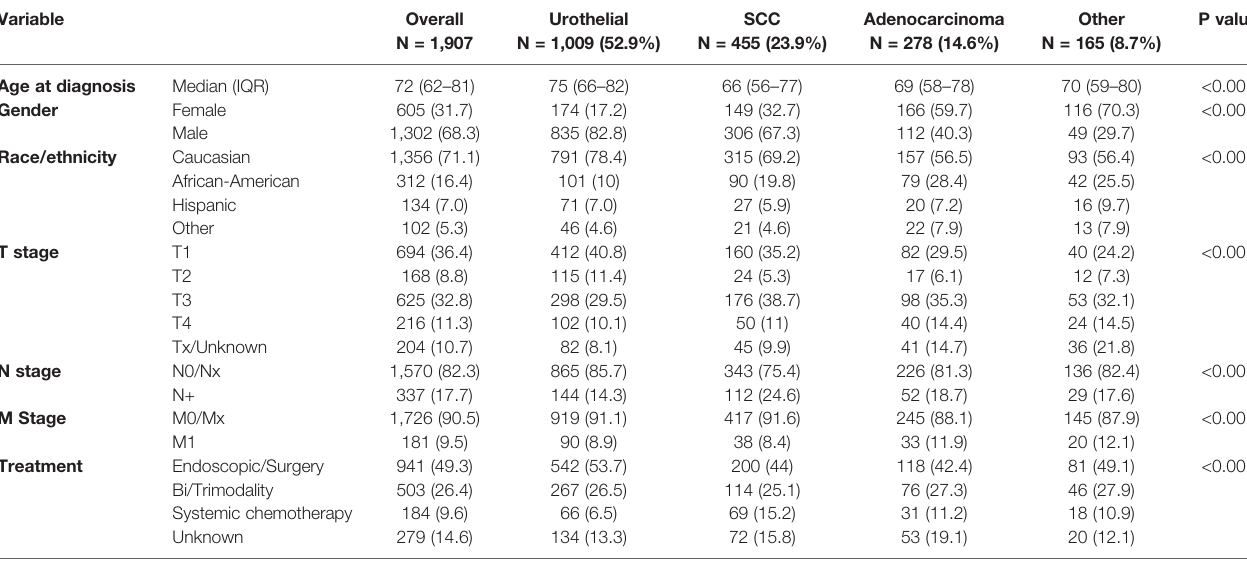
TABLE 1 | Characteristics of urothelial vs. non-urothelial urethral cancer patients.